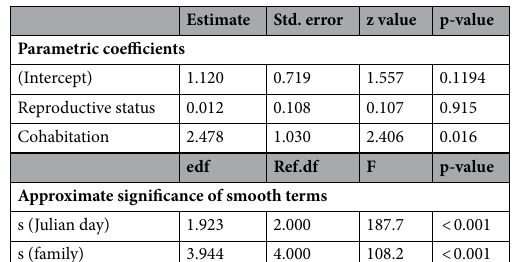
Estimate Std. error z value